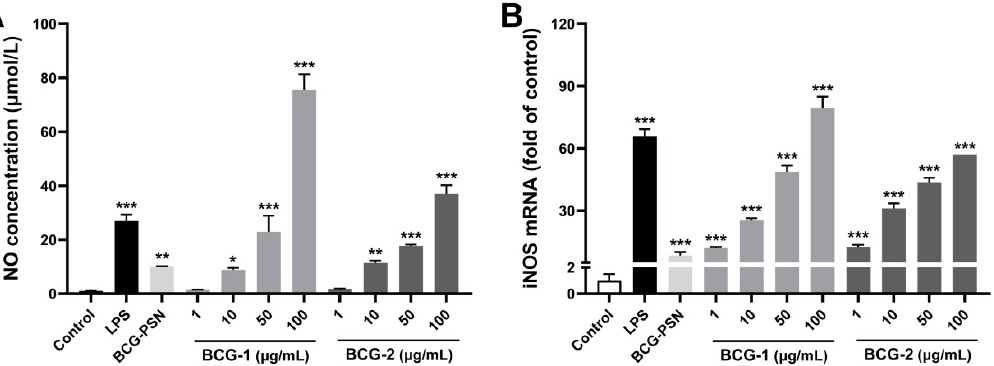
Figure 5. Effects of LPS, BCG-PSN, BCG-1, and BCG-2 on the production of NO ( A ) and mRNA expressions of iNOS ( B ) in RAW264.7 cells. LPS was at 100 ng/mL, BCG-PSN was at 87.5 μ g/mL. * p < 0.05, ** p < 0.01, and *** p < 0.001 vs. control, one-way ANOVA, Dunnett’s multiple comparisons test.